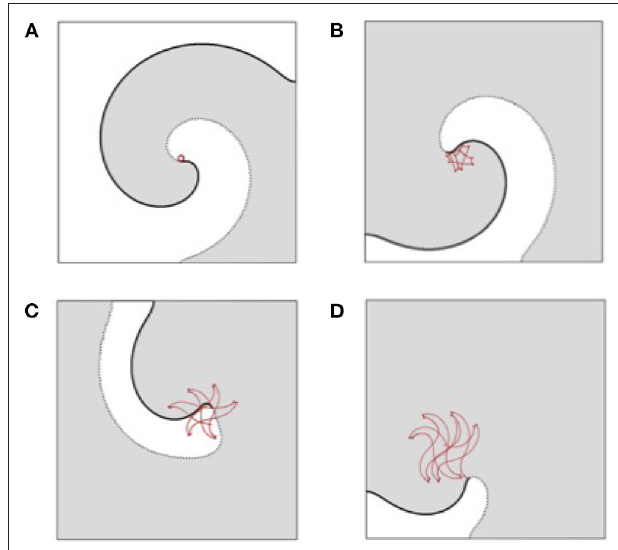
FIGURE 8 | Four examples of the trajectories of the spiral wave tip observed within the gray parameter region shown in Figure 5 with b = 0.01 and (A) a = 0.22, (B) a = 0.4, (C) a = 0.6, (D) a = 0.8.